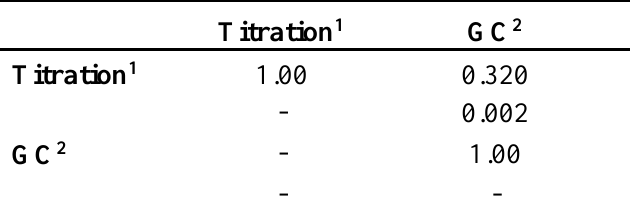
Table 12 . Pearson Correlation Coefficients and P-values for two measures of iodine value in jowl fat of pigs fed a control